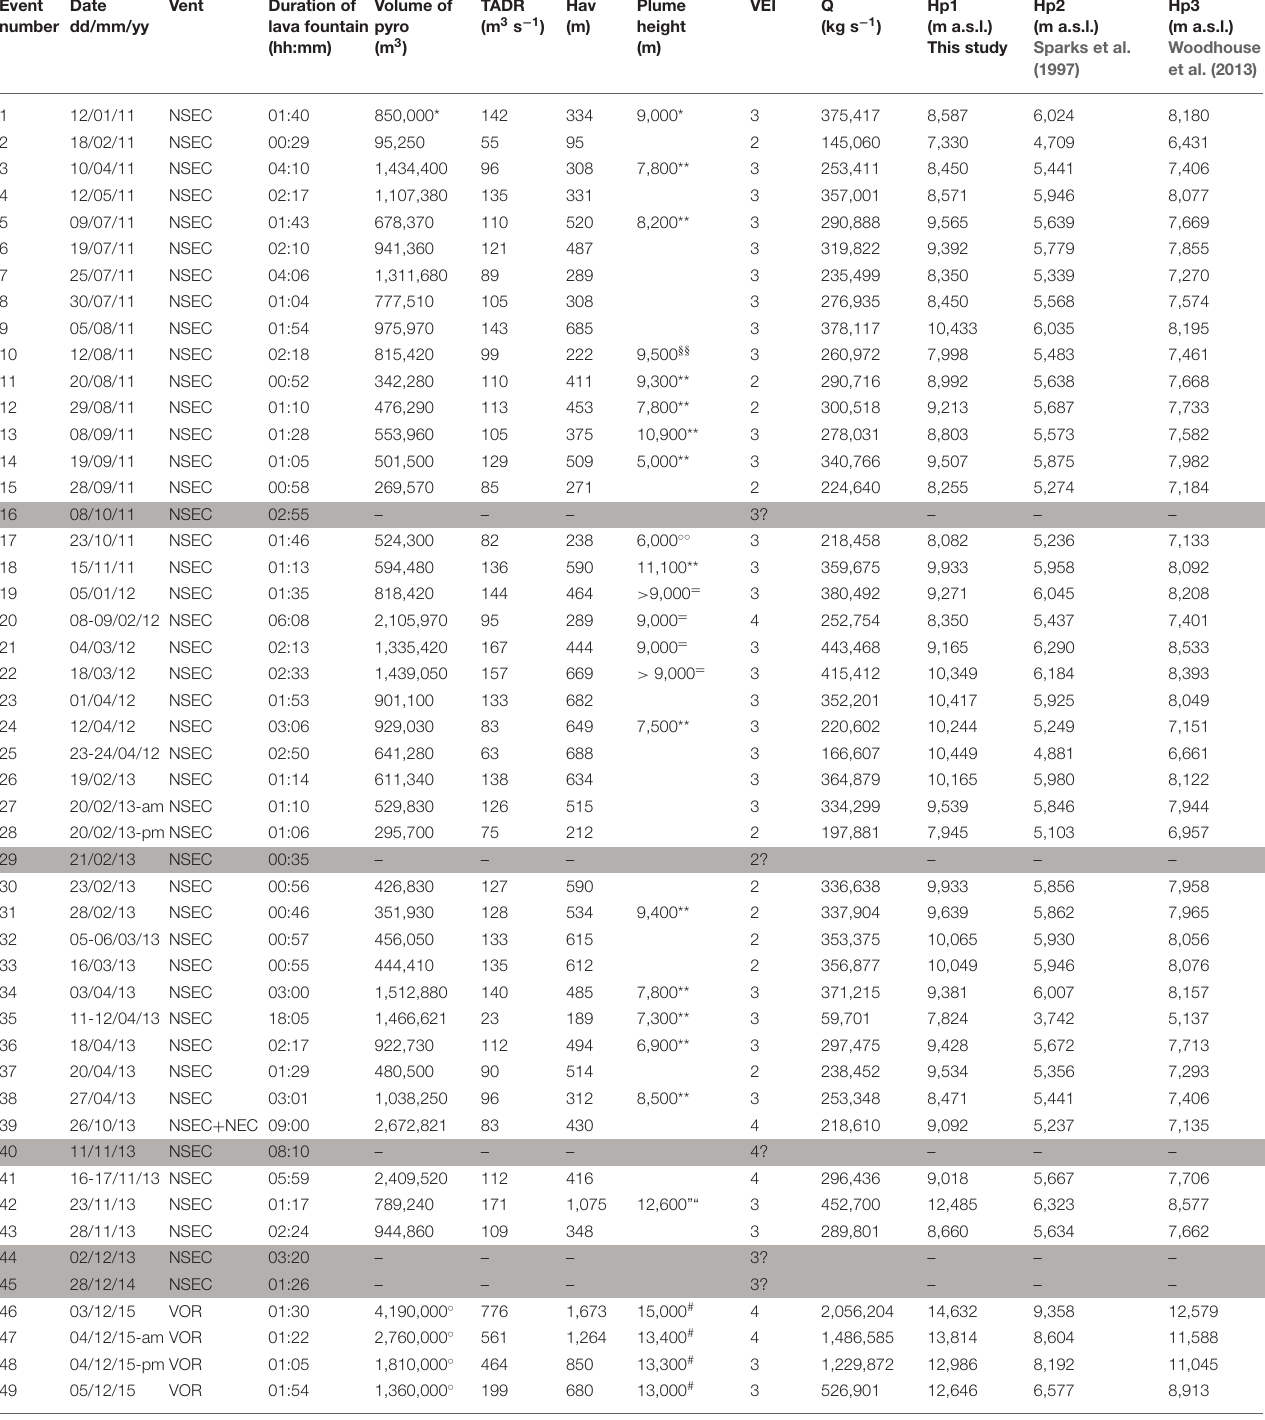
TABLE 5 | Event numbers (first column) and dates (second column) of lava fountains of NSEC (events from 1 to 45) and VOR (events from 46 to 49). Event Date number dd/mm/yy